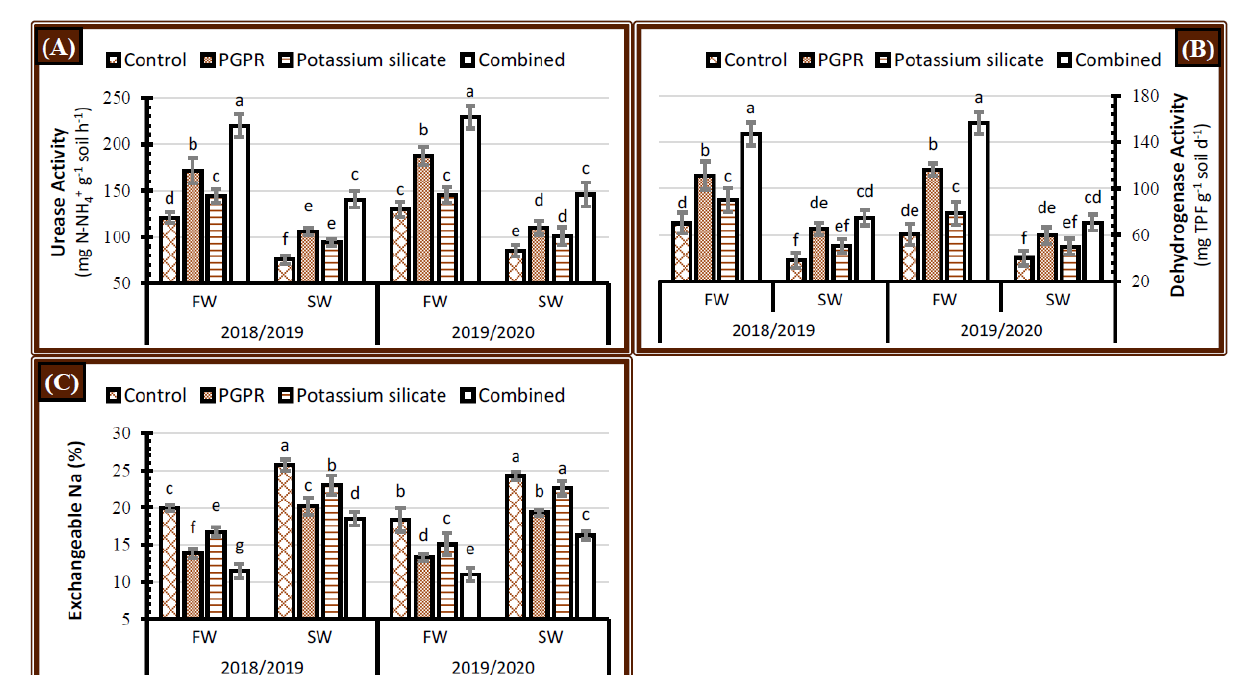
Figure 1. Effect of application of plant growth-promoting rhizobacteria (PGPR), potassium silicate and their combination on ( A ) urease activity and ( B ) dehydrogenase activity ( C ) exchangeable sodium percentage in faba bean under two irrigation types, i.e., fresh water (FW) and saline water (SW) in salt-affected soil during two growing seasons 2018/2019 and 2019/2020. The data are means ± SD (error bar) of four replicates. Means values that have the same lower-case letter in each column per season are not significant according to Duncan’s Multiple Range